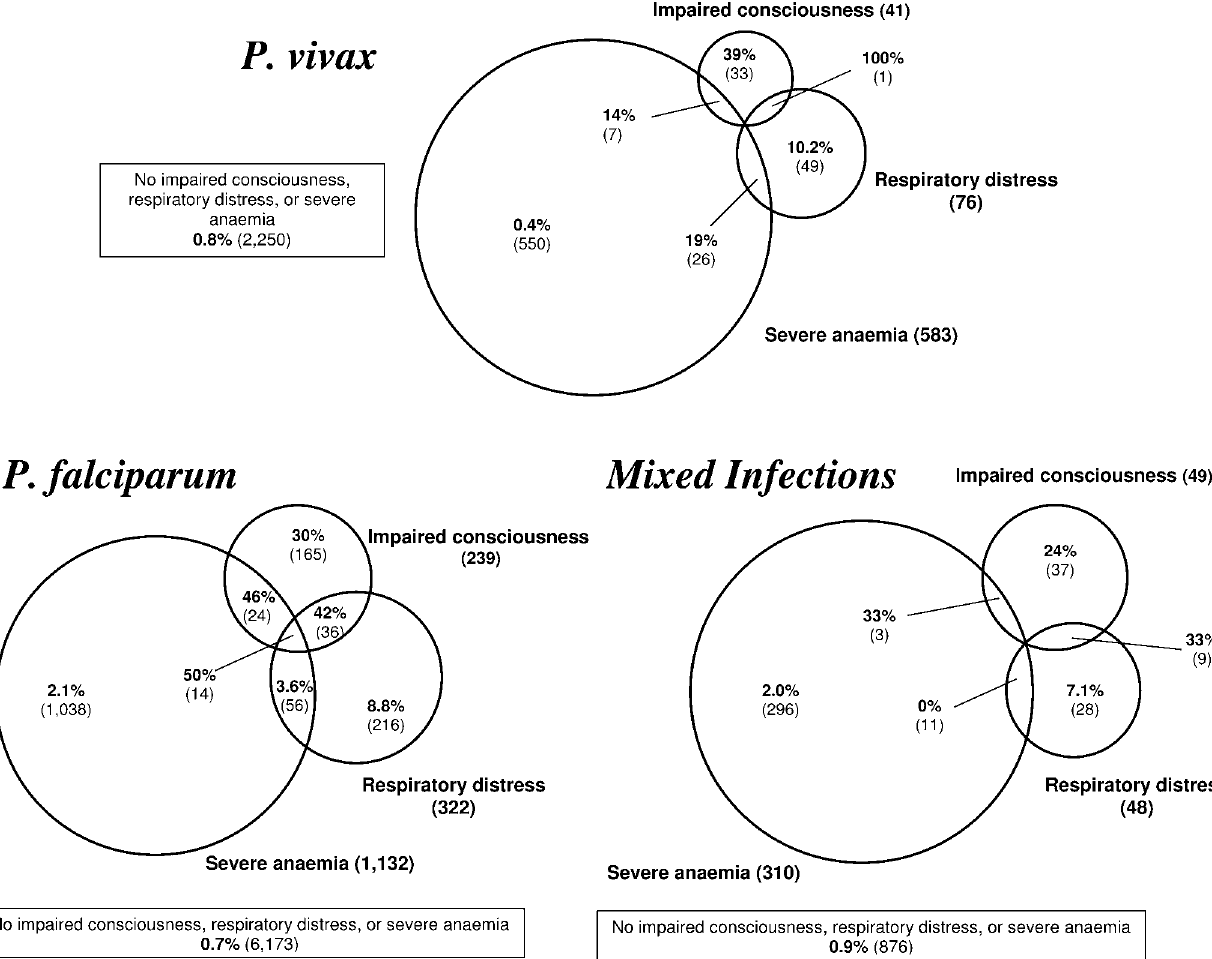
Figure 5. Prevalence, Overlap, and Mortality for Criteria of Severe Malaria Associated with Infection of P. falciparum , P. vivax , and Mixed Infections Total numbers are given in parentheses, and mortality is given as a percentage. The sizes of the circles represent the relative proportions of patients with malaria with different severe manifestations of disease for each species. Data on mortality are missing in 129 (1.1%) patients, 95 with P. falciparum , 21 with P. vivax , and 13 with mixed infections.